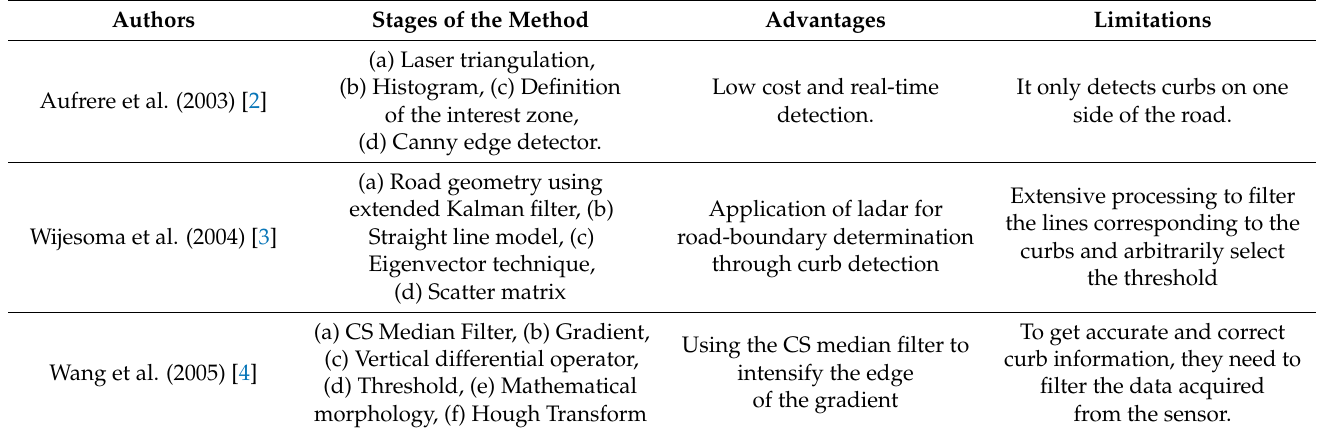
Table 2. Curb detection